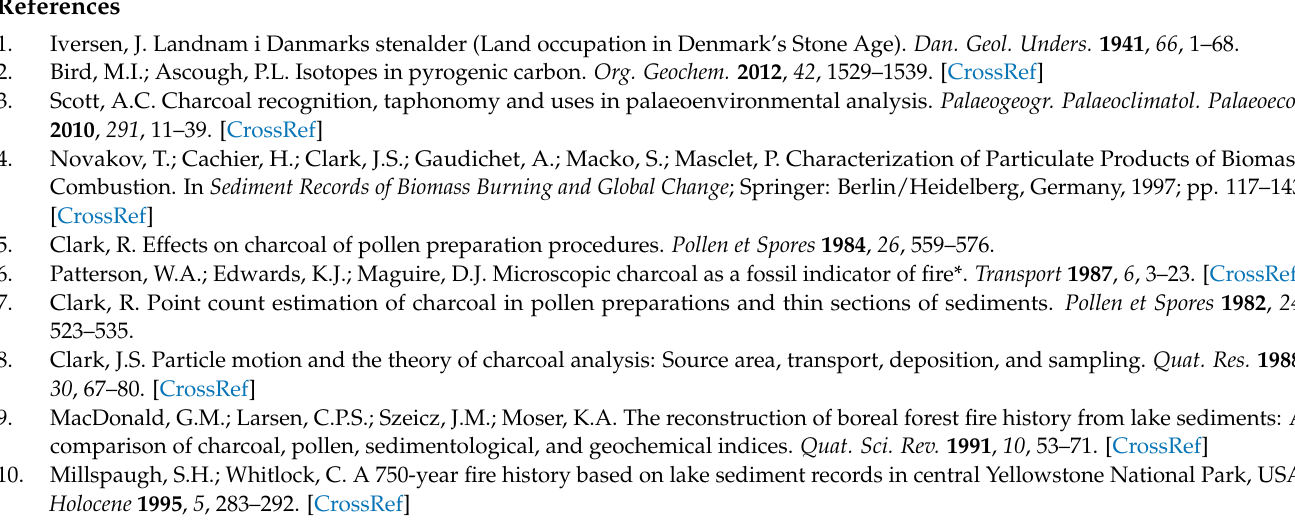
and 75th quartile values. The whiskers represent the minimum and maximum values. Outliers are represented by red dots. Figure S3: (A) Charring Intensity ( ◦ C.s.10 6 ) of WB3 treatment groups. On the left-hand side (A) mean CI is presented as a black line and dots. Maximum and minimum values are presented as the grey shaded area. In (B) the range of Charring Intensity is presented for the five treatment groups. Figure S4: Tukey’s HSD test of significance of mean Charring Intensity for each treatment group of WB3. Group comparisons that deviate to the left or right of 0.0 indicate significant differences between groups. This revealed that T2-T1, T3-T2, T4-T2, and T5-T2 showed significant differences. Figure S5: The results of the two treatment groups on LC2. Charcoal concentration is presented as area (mm 2 /cm 3 ) and count (No./cm 3 ). Charring Intensity is presented as a mean (black line) and minimum and maximum values (grey shading). In the H 2 O treatment group, values at ~550 cm are truncated at 200 (area) and 1500 (count), respectively, to highlight variation in depths with lower charcoal concentration. Table S1: Results of Tukey’s HSD test of significance on mean Charring Intensity for